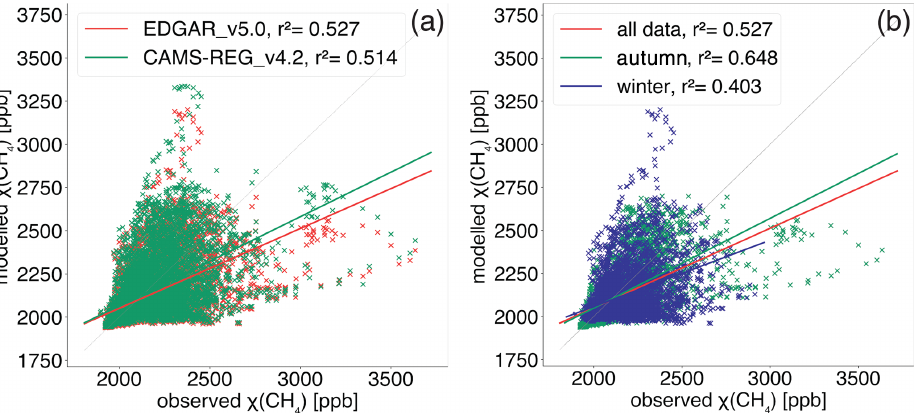
Figure 5. Correlation between observed and modelled χ (CH 4 ) values, using (a) the EDGAR v5.0 (red) or the CAMS-REG-GHG v4.2 (green) inventories and (b) different time periods: autumn (14 September to 15 November 2018; green) or winter (15 November 2018 to 15 March 2019; blue) computed using EDGAR